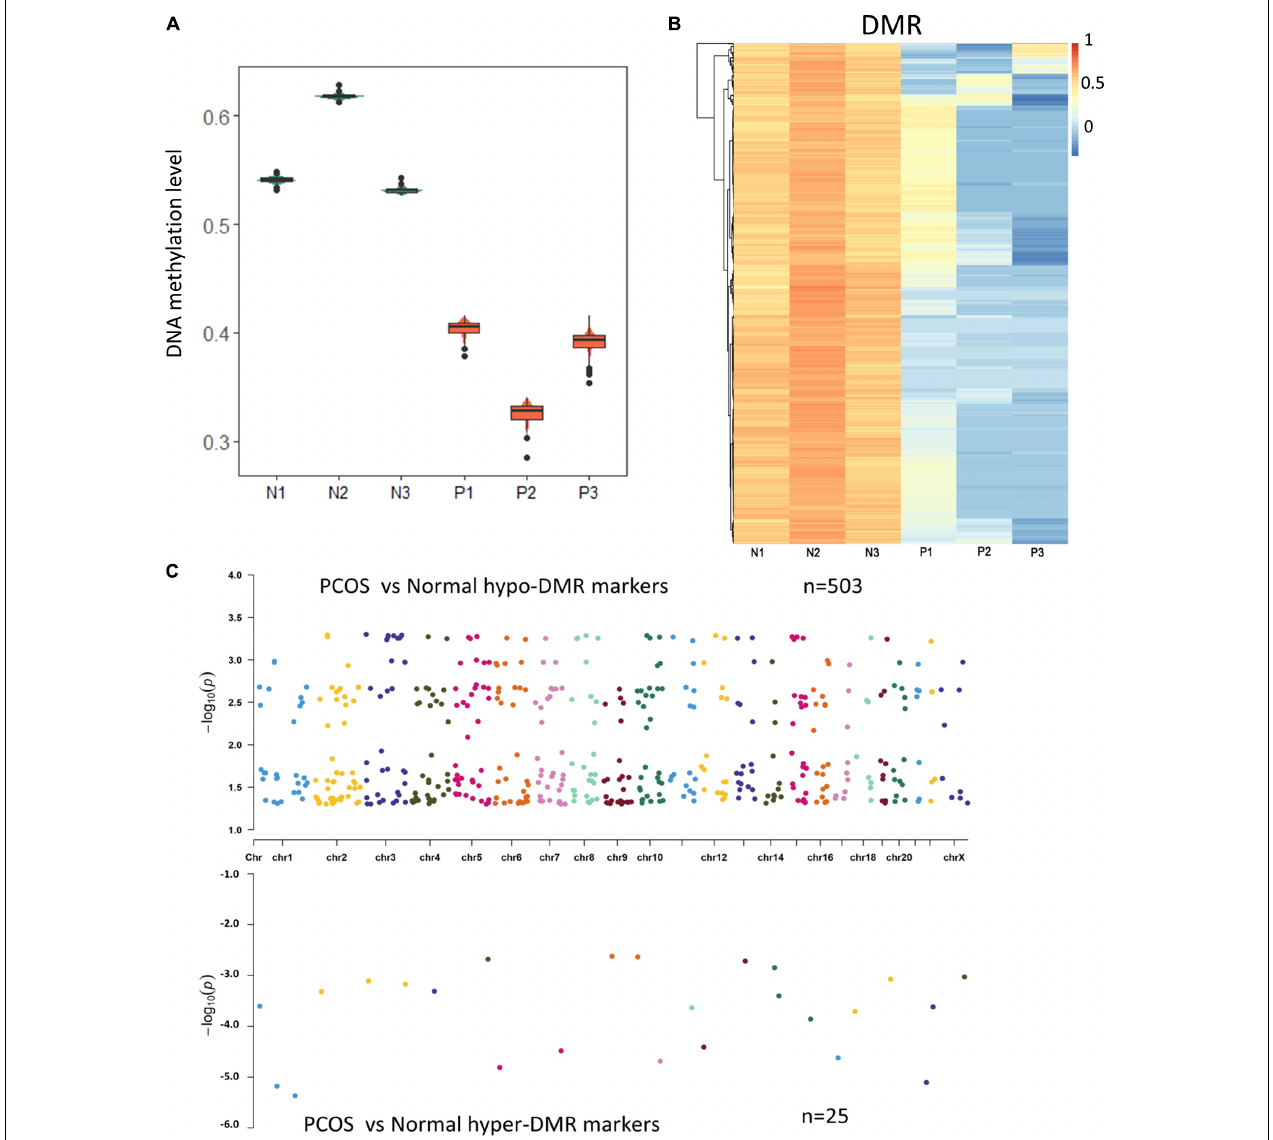
FIGURE 2 | The methylome changes of human PCOS. (A) Violin plot of DNA methylation levels of PCOS and control GCs. (B) Heatmap of DMRs between PCOS and control GCs. Each row represents a DMR, and averaged CpG methylation levels are represented by different colors. (C) Chromosome distribution of DMRs. The number of dots represents the distribution of DMR across different